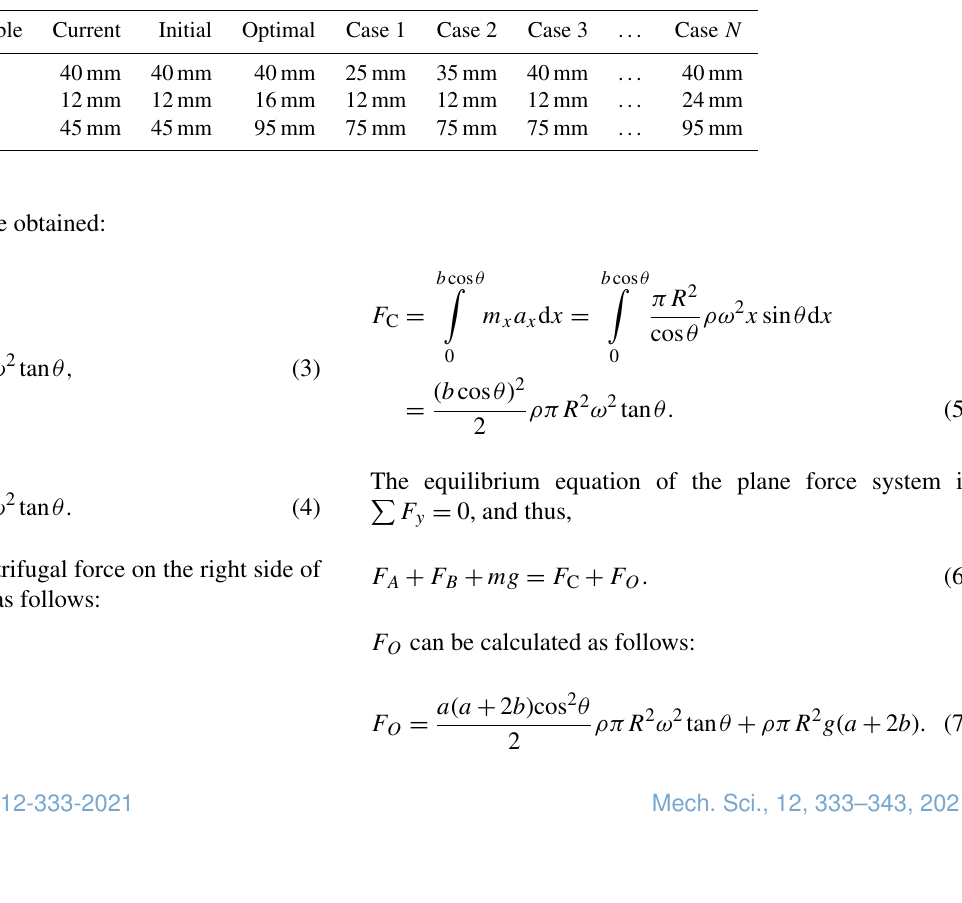
Table 2. SOLIDWORKS optimization